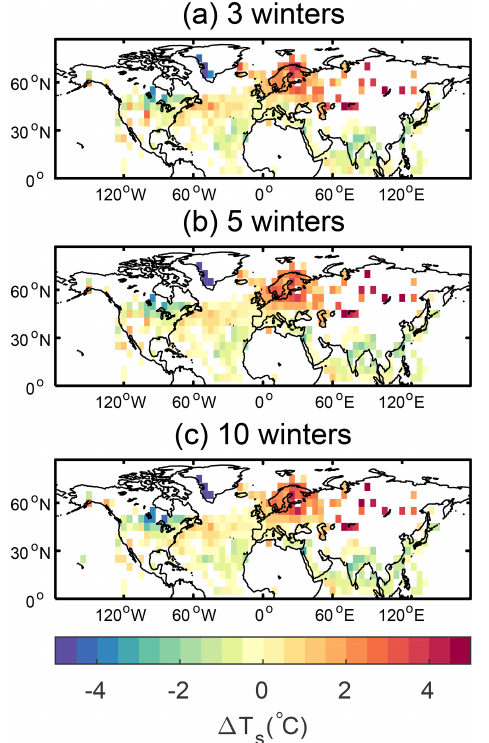
Figure 2. Post-Krakatau CRUTEM surface temperature anomalies ( (cid:49)T s ) in DJF, using (a) 3, (b) 5, and (c) 10 winters for the reference period.